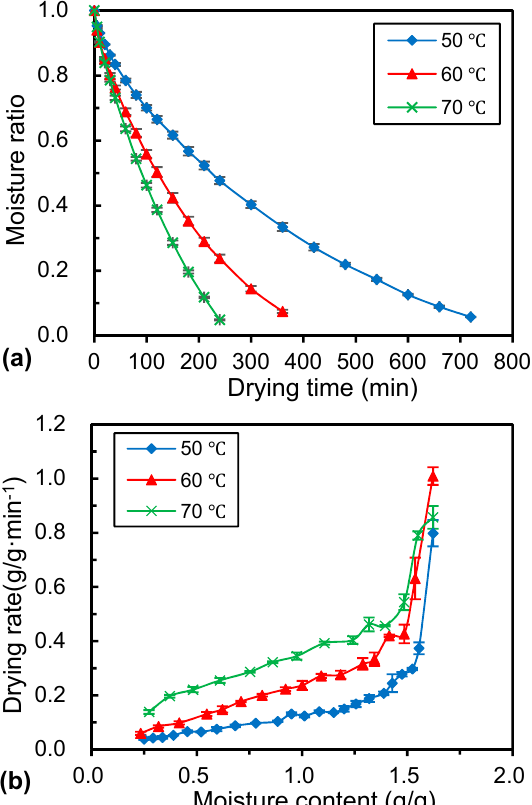
Figure 2. Drying kinetics ( a ) and drying rate ( b ) curves Ophiopogonis Radix under different drying temperatures.